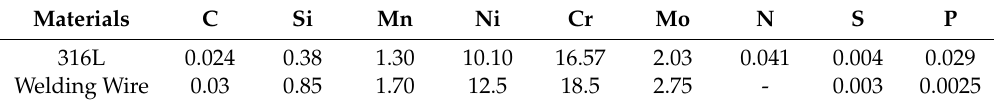
Table 1. Chemical compositions of 316L austenitic stainless steel and welding wire (wt. %). Materials C